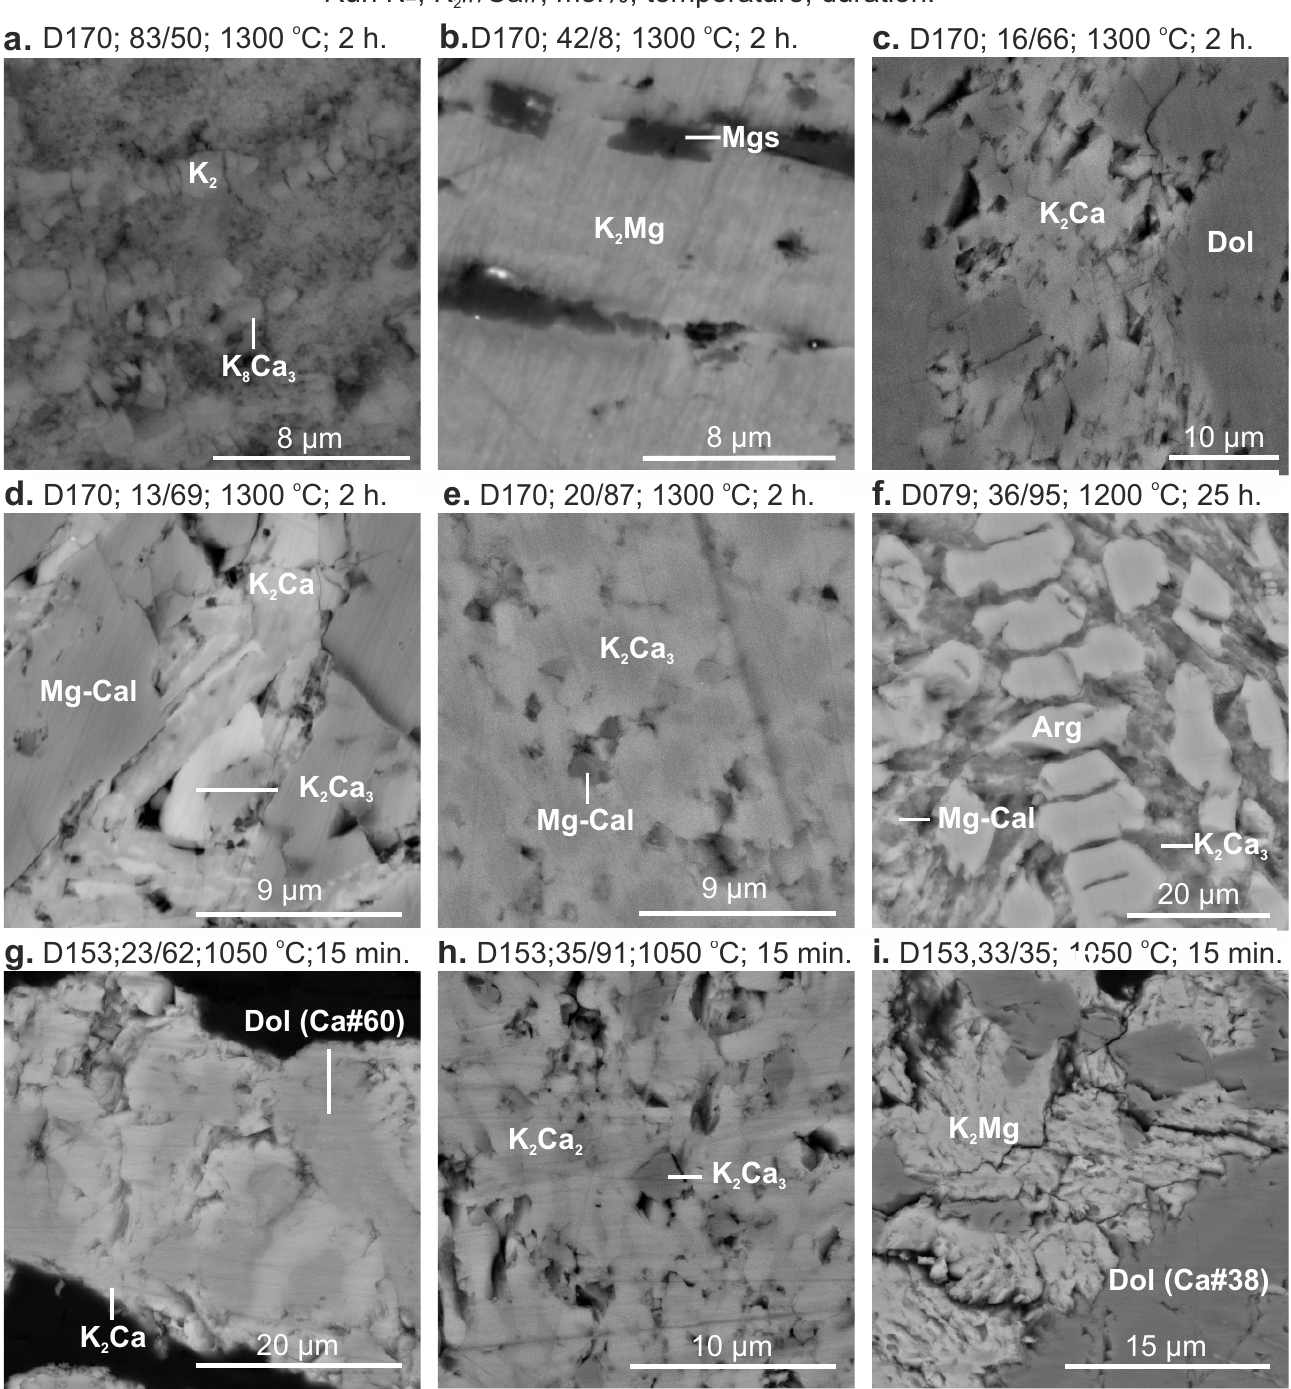
Figure 1. Backscattered electron images of quench products were obtained in the system K 2 CO 3 –CaCO 3 –MgCO 3 at 6 ( a – f ) and 3 ( g – i ) GPa. K 2 —solid solution of CaCO 3 in K 2 CO 3 ; K 2 Ca—K 2 Ca(CO 3 ) 2 bütschliite; K 2 Ca 2 —K 2 Ca 2 (CO 3 ) 3 ; K 2 Ca 3 —K 2 Ca 3 (CO 3 ) 4 ; Arg—aragonite; Mg-Cal—Mg-bearing calcite; Dol—dolomite; Mgs—magnesite.